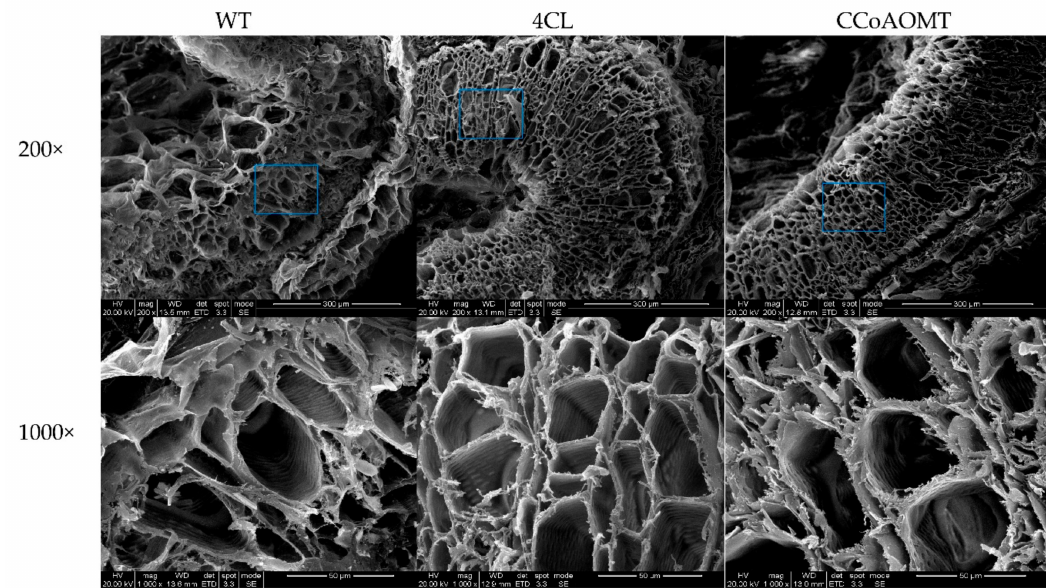
Figure 9. Representative SEM micrographs of tobacco stem cross sections, taken at 200 × and 1000 × . The first to third columns show wild type, Cf4CL and CfCCoAOMT transfected tobacco respectively. The pictures at 1000 × show part of the pictures taken at 200 × , indicated by a blue